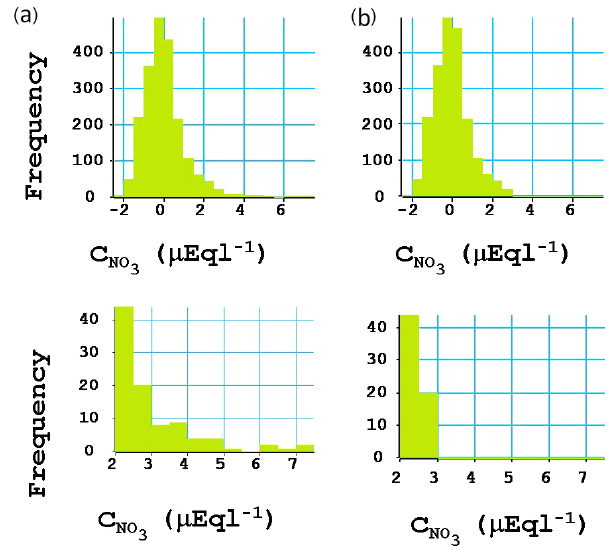
Figure 2. Panel (a) top: histogram of raw NO 3 concentration; bot- tom: zoom for the highest concentration values. Panel (b) top: his- togram of the raw NO 3 concentration thresholded; bottom: zoom for the highest concentration values. All histograms have bars of equal width, which is 0.5µEql − 1